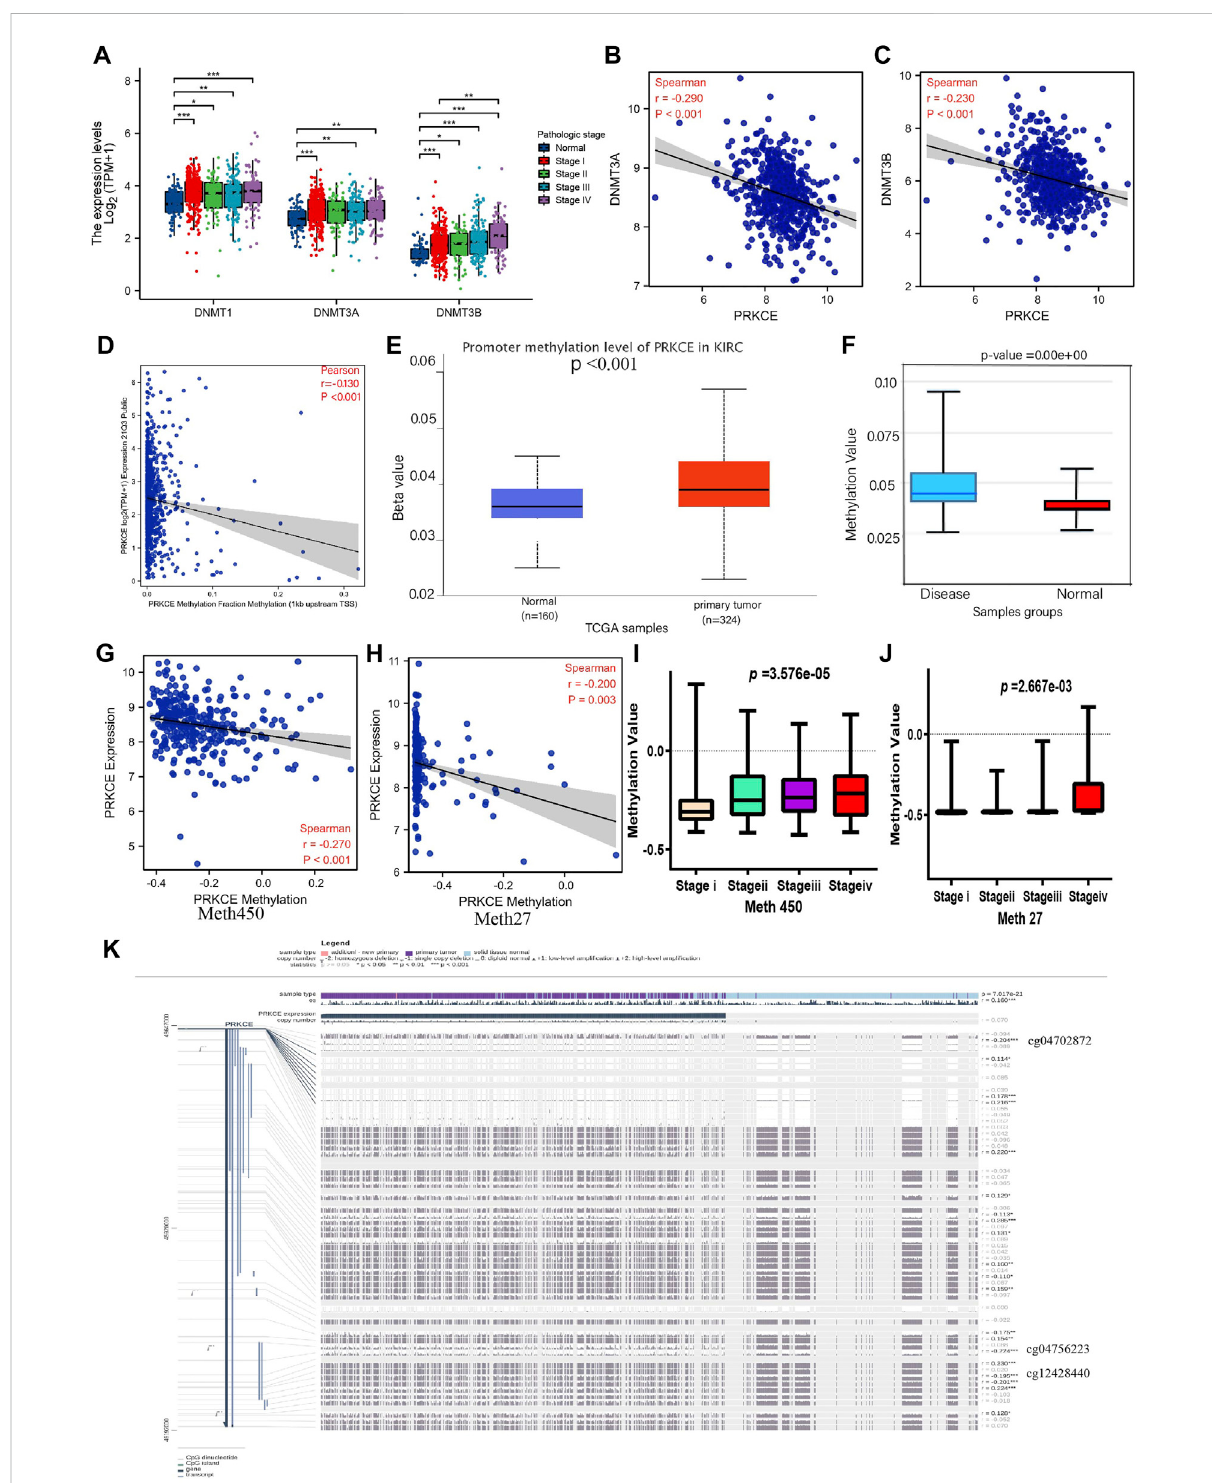
FIGURE 4 MethylationanalysisofPRKCEinKIRC. (A) DNMT1,DNMT3A,DNMT3B expressionindifferentpathologicalstagesofKIRC. (B,C) Thecorrelation between PRKCE expression and DNMT3A and DNMT3B was analyzed using the LinkedOmics database. (D) The correlation between PRKCE methylation and expression level analysis using CCLE data in kidney cancer cells. (E) The promoter methylation level of PRKCE in tumor tissues ( n = 324)andnormaltissues( n =160)fromUALCANdata. (F) MethylationlevelwasevaluatedusingtheDiseaseMethversion2.0database. (G,H) The correlationbetweenPRKCEmethylation andthePRKCE expression levelwasanalyzedusingIllumina 450and27KdatainKIRC. (I,J) Methylationwas evaluated using IIIumina 450 and 27K data in different pathological stages. (K) The methylation site of PRKCE DNA sequence association with gene expression was visualized using